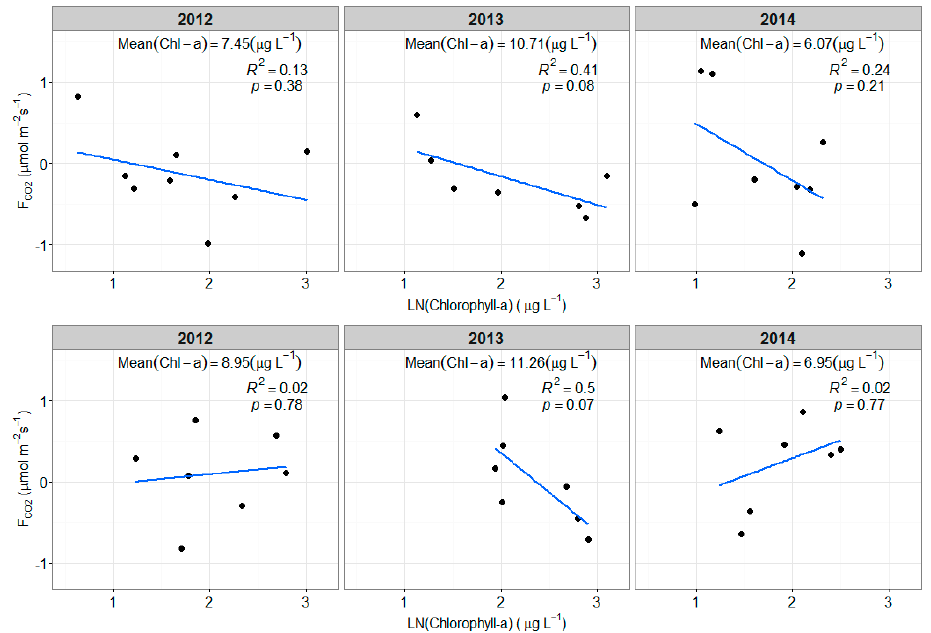
Figure 8. Changes in the relationship between monthly mean chlorophyll-a and F CO2 over different years (2012–2014) at the LightH ( top ) and Crib sites ( bottom ). The relationship was stronger in 2013, which experienced larger algal blooms than that in other years.